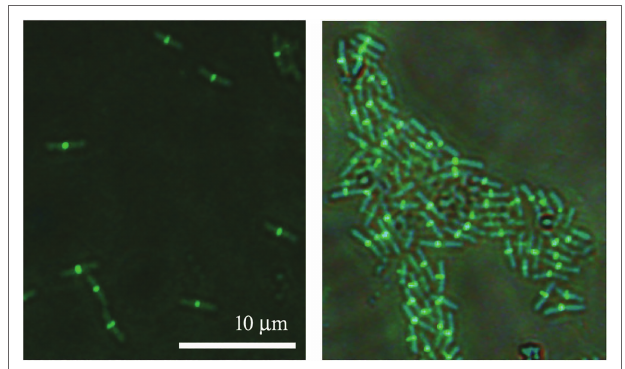
FIGURE 4 | Subcellular localization of ZapAL-GFP. Fluorescence images of PAO1 cells expressing pME6032-zapAL-gfp are examined after 1.5 h at 37 ° C